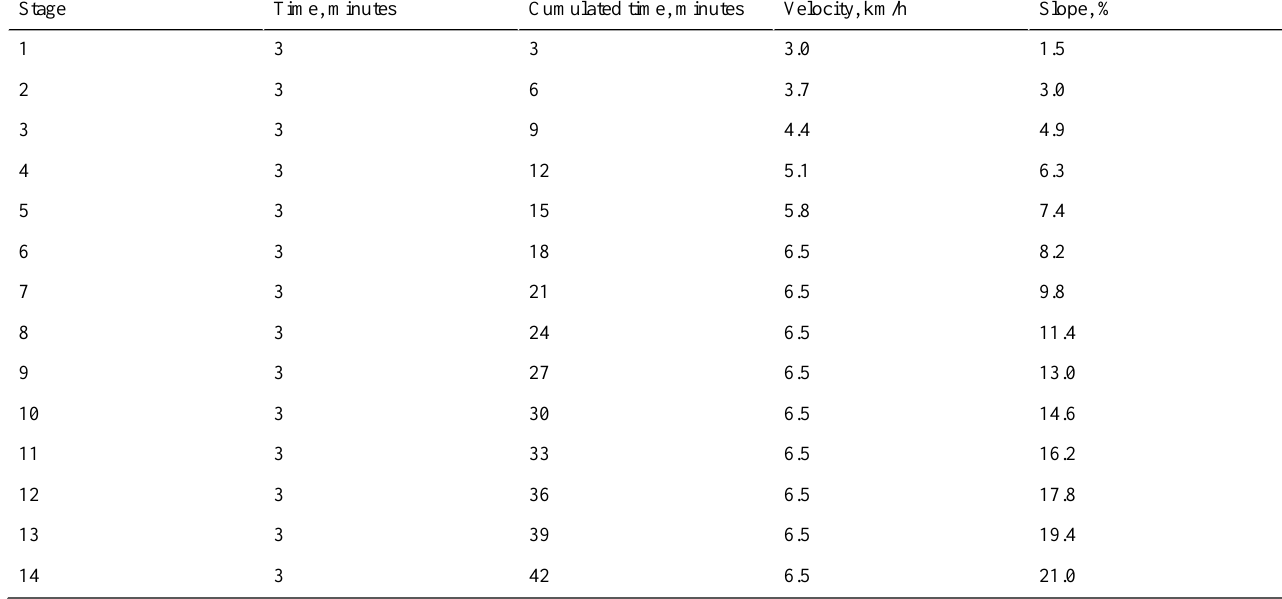
Table 2. Modified walking protocol [28].